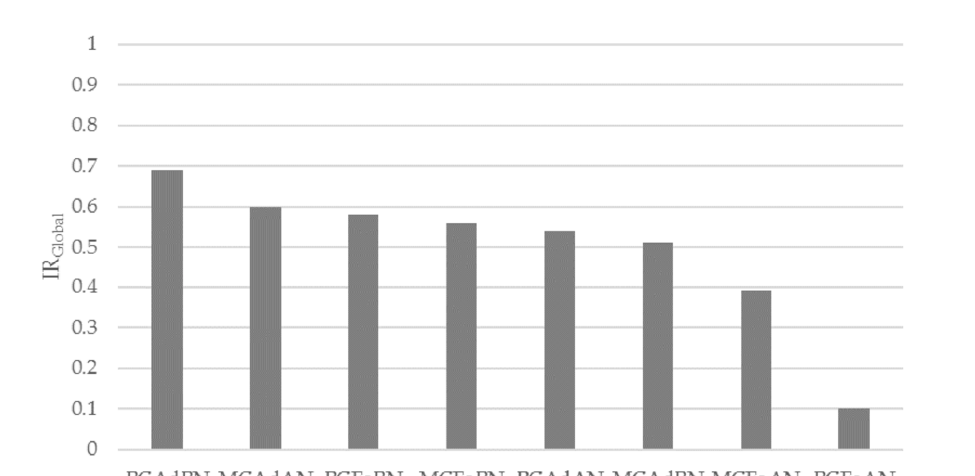
Figure 6. IR Global for each combination of factors: configuration (MC: monopolar concentric; BC: bipolar concentric), material (Ad: adhesive; Fo: foam) and position (AN: above navel; BN: below navel).